Question: What form of chart is displayed?
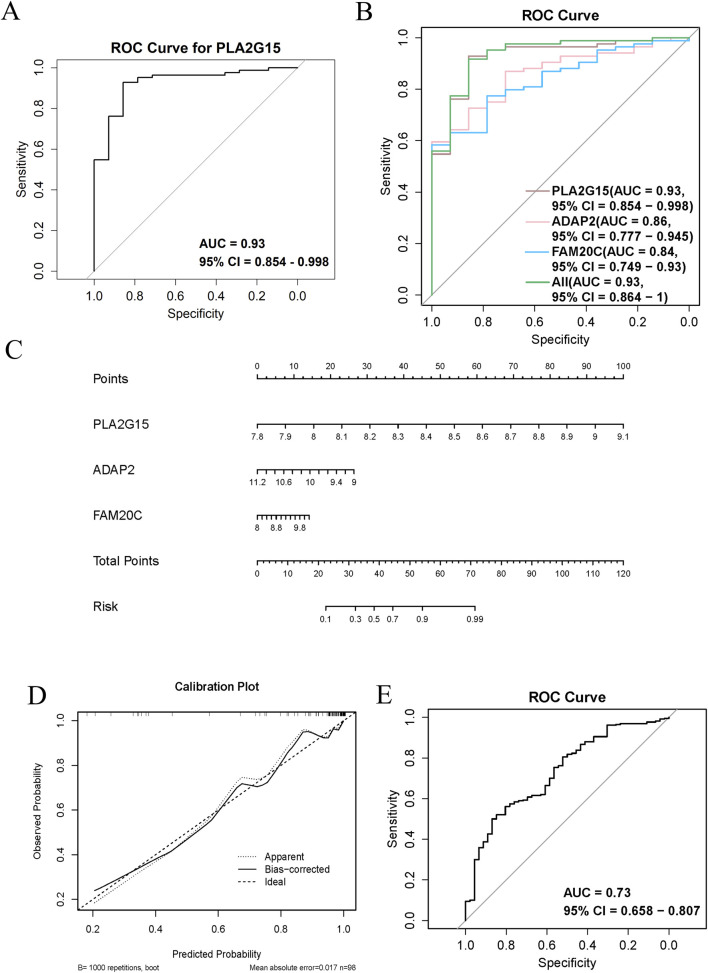
Answer: line